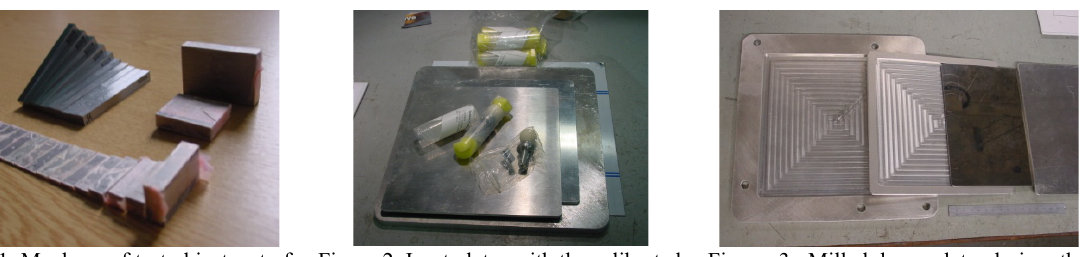
Figure 1. Mock-up of test object: set of Steel Slip Gauge Set M32, Calibration Grade 1 and Angle Block Set, length gauges to test step height and as length bar (www.mscjlindustrial.co.uk).